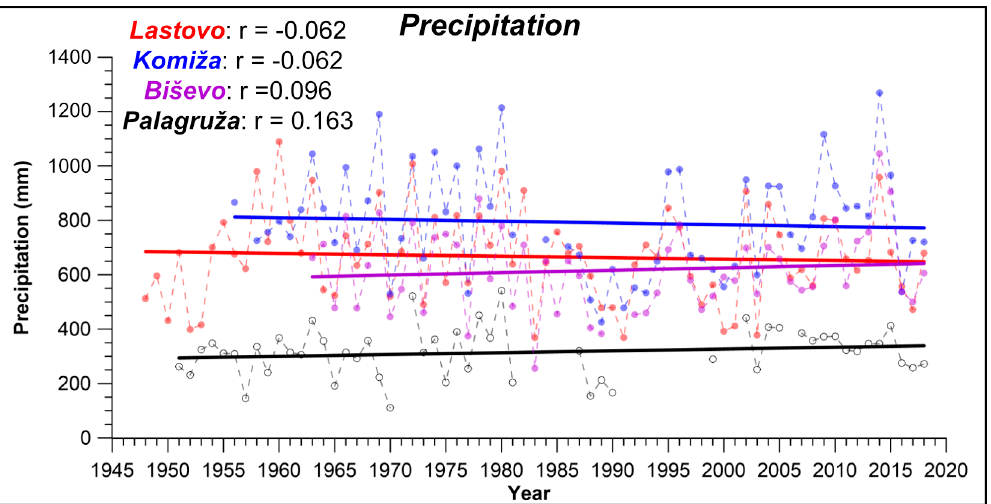
Figure 7. Annual precipitation time series. The linear correlation coe ffi cient r was calculated from the total